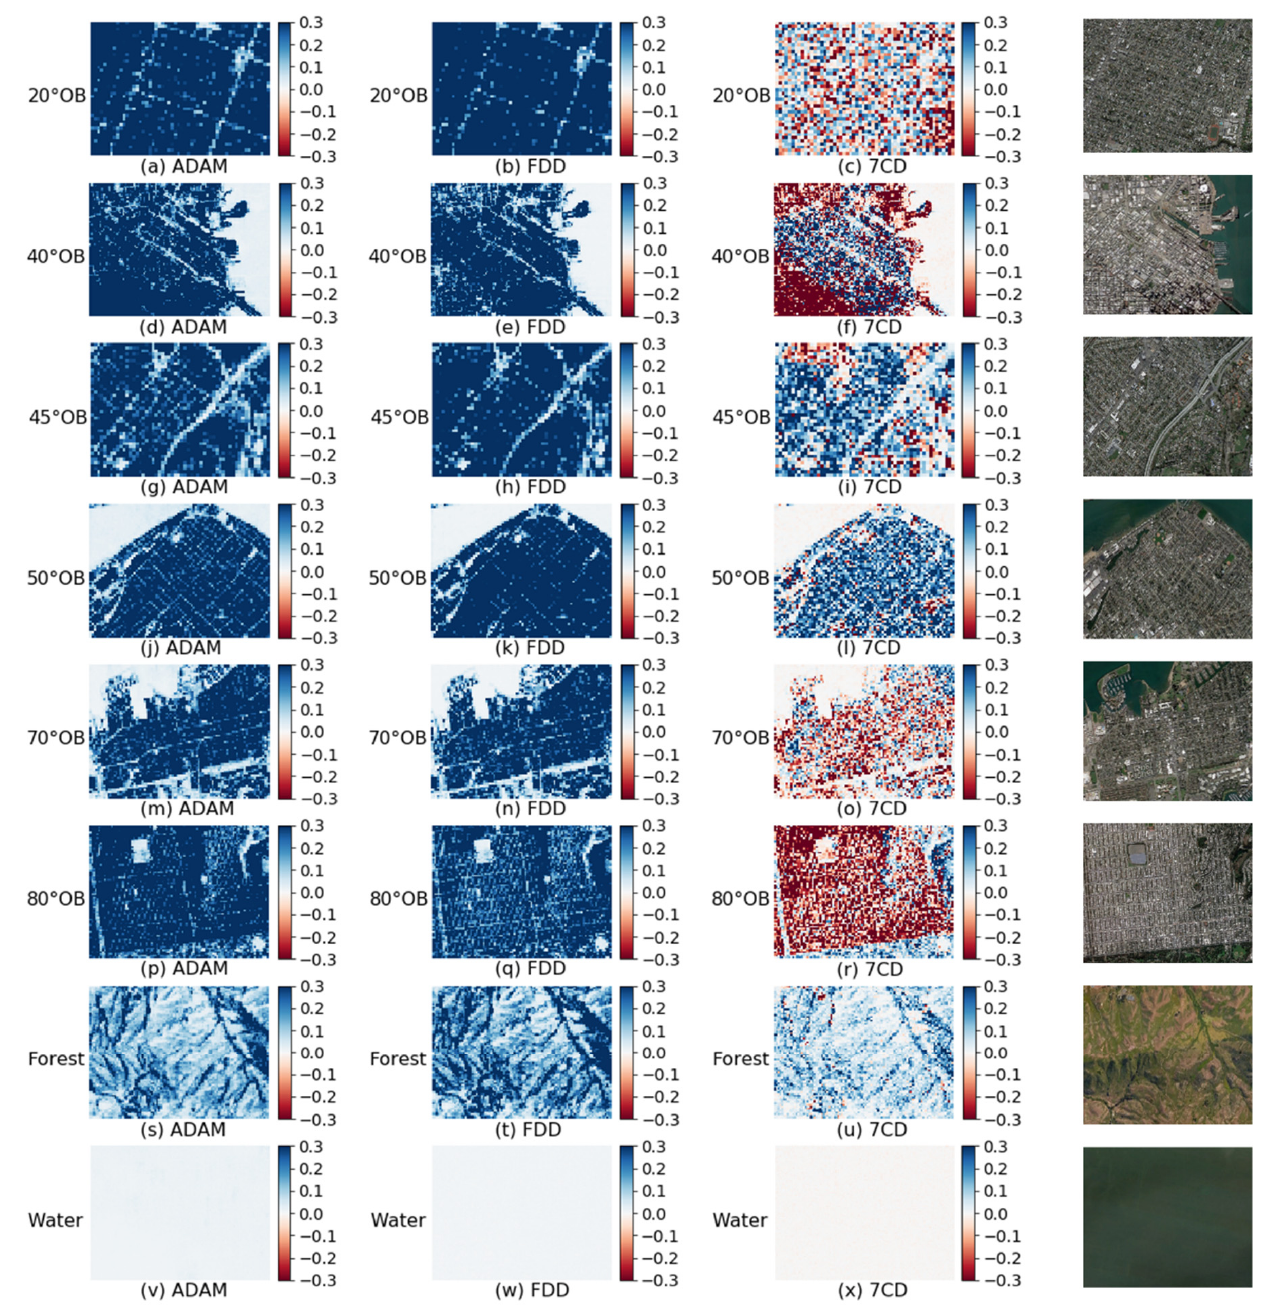
Figure 15. The output map of volume scattering power P v estimated by ADAM, FDD, and 7CD for 8 types of samples over San Francisco, USA.